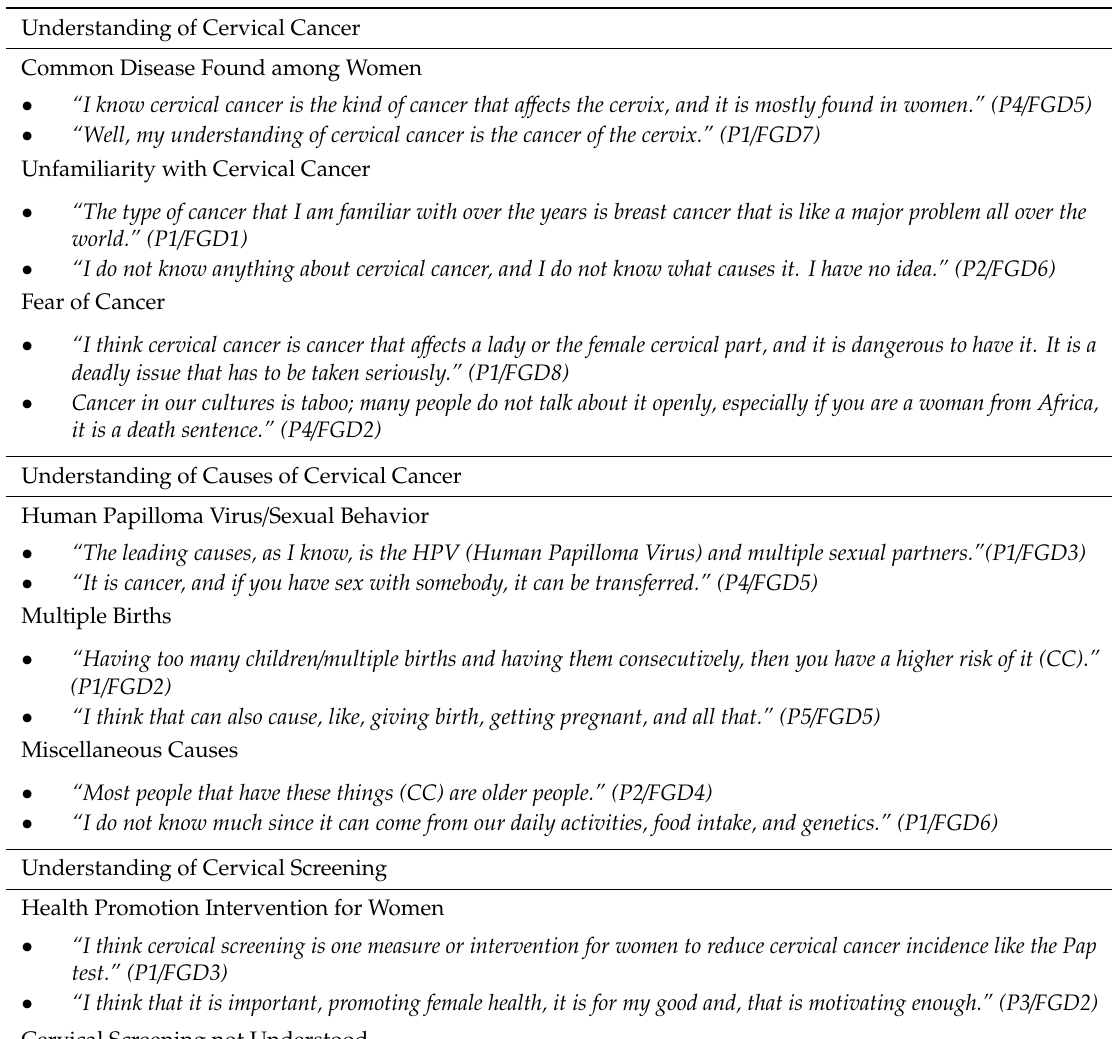
Table 2. Examples of quotations of perceptions of cervical cancer and